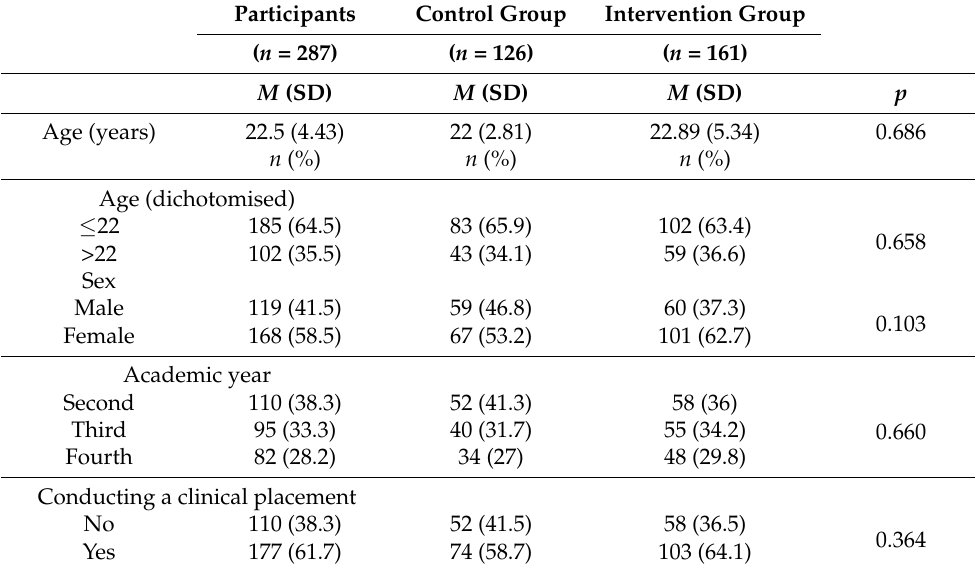
Table 1. Characteristics of the participants.